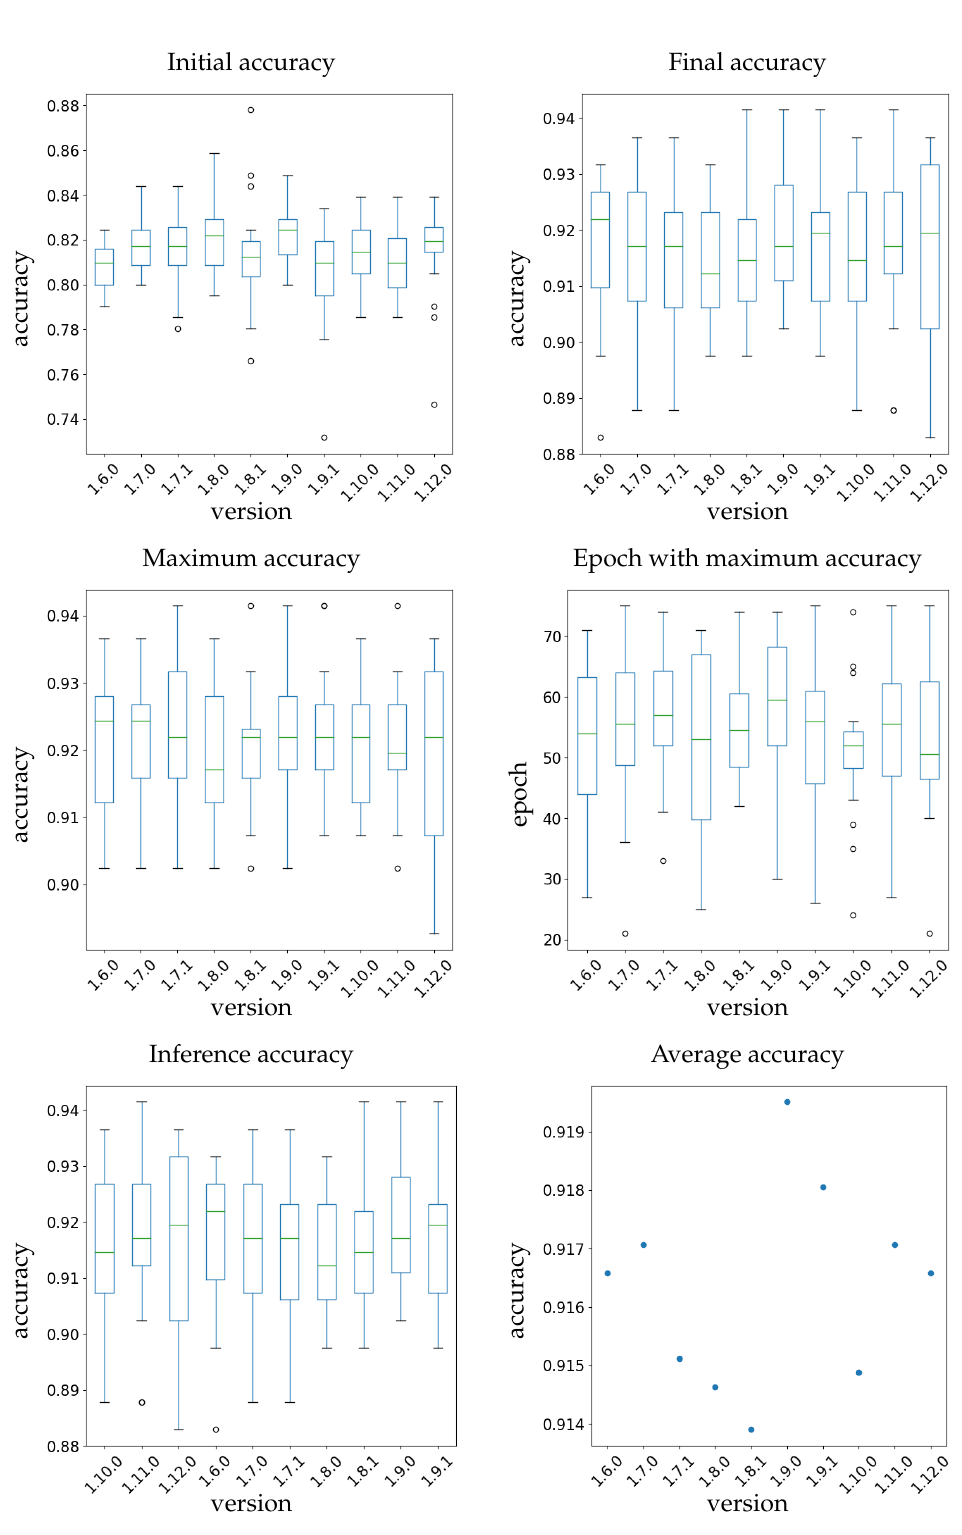
Figure 9. The results for the heart-disease dataset using